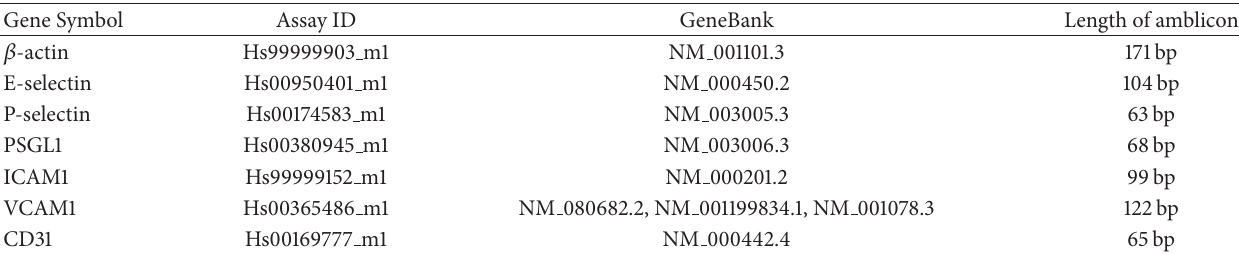
Table 1: TaqMan Gene Expression Assays used for